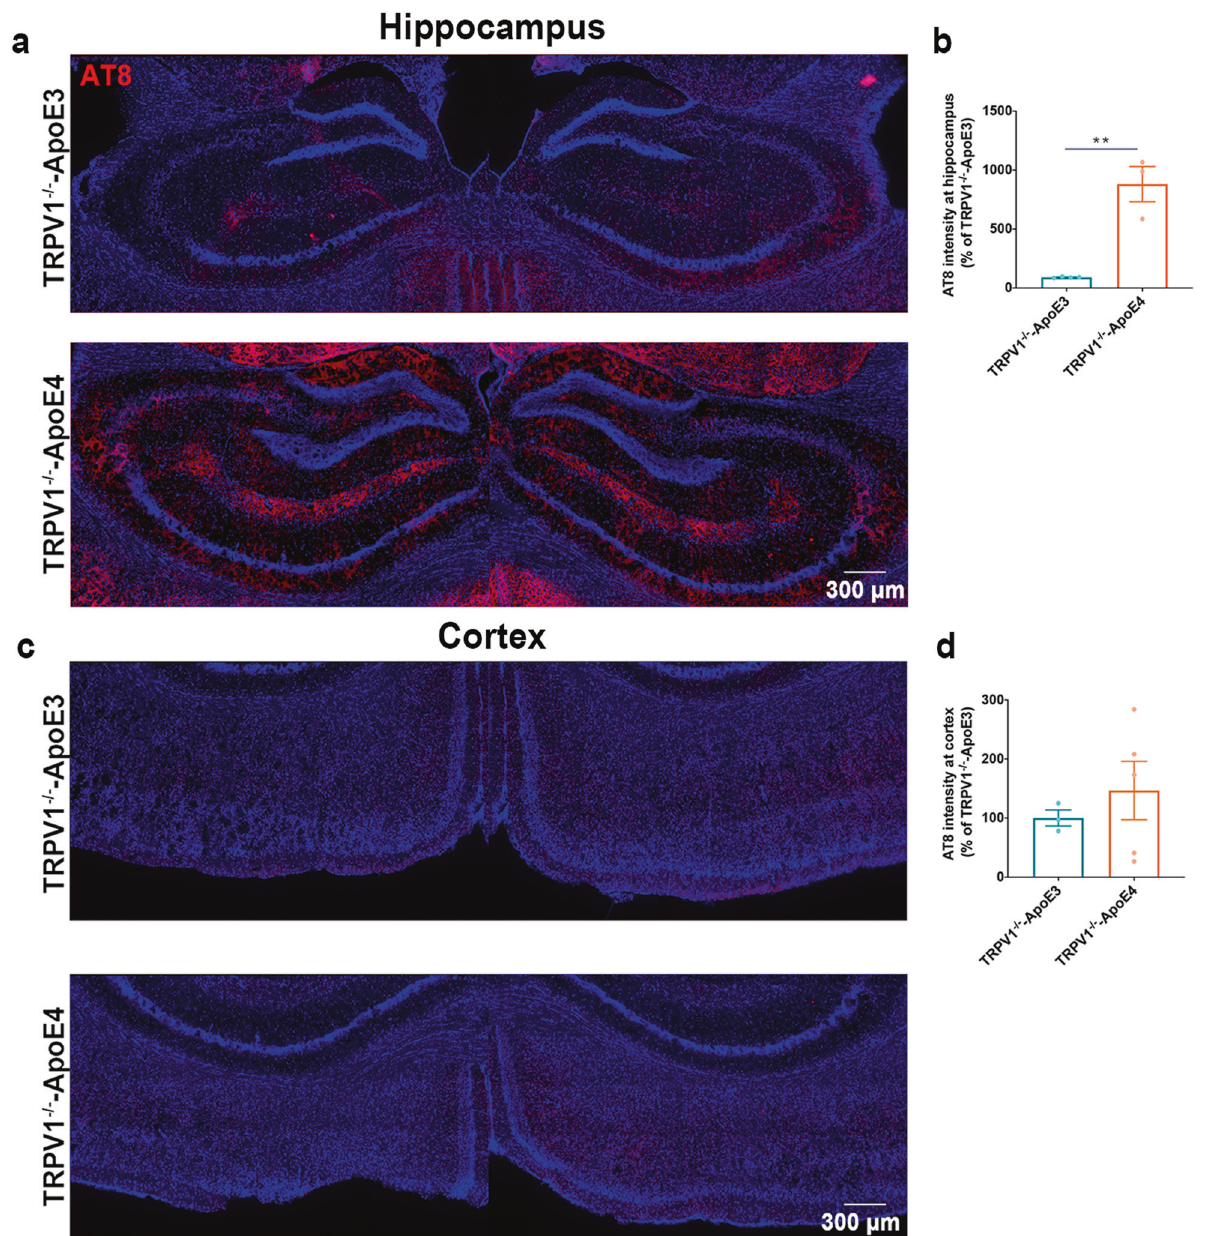
Fig. 9 TRPV1 genetic de fi ciency exacerbated ApoE4-induced tau pathology. a – d Phosphorylated tau-covered area in the cortex and hippocampus of TRPV1 − / − -ApoE3 and TRPV1 − / − -ApoE4 mice. ( n = 3, biological replicates). Statistical tests: two-sided Student ’ s t test ( b , d ). Data represent the mean ± s.e.m. ** p < 0.01. Scale bars, 300 μ carrying the APOE4 allele accumulated more lipid droplets in TRPV1 activation with capsaicin reversed neuronal lipid droplet neurons and microglia, but not astrocytes, than normal indivi- accumulation and autophagy impairment in primary neurons duals. Lipid metabolic LC ‒ MS analysis of the peripheral plasma, in vitro. Capsaicin also rescued memory impairment, tau which has been shown to re fl ect lipid metabolic changes in AD, pathology, and neuronal autophagy dysfunction in ApoE4 HFD revealed downregulated medium- and long-chain FAs in ApoE4 mice. Activation of TRPV1 decreased neuronal lipid droplet mice compared with ApoE3 mice (Fig. 1c – e). Enrichment analysis accumulation and induced upregulation of microglial phagocy- showed that pathways related to the in fl ammatory response, tosis of synapses in ApoE4 HFD mice. TRPV1 gene de fi ciency energy metabolic process, cholesterol metabolism, and insulin exacerbated recognition and neuronal immune homeostasis resistance were enriched in the ApoE4 mouse brain (Fig. 1i). impairment in ApoE4 HFD mice. ApoE4 impaired bioenergetic function and neurite outgrowth in Here, we report that ApoE4 disrupted the neuronal lipidome. primary neurons. We evaluated the effects of the ApoE isoform on Lipidomics and unbiased genome-wide screens were combined oxidative phosphorylation in primary neurons. ApoE4 neurons with functional and genetic characterization in mice to demon- exhibited lower basal respiration and maximal respiration than strate that the presence of the APOE4 allele led to lipid ApoE3 controls (Fig. 3j). As a key metric of neuronal function, the homeostasis impairment and immune dysfunction. AD patients